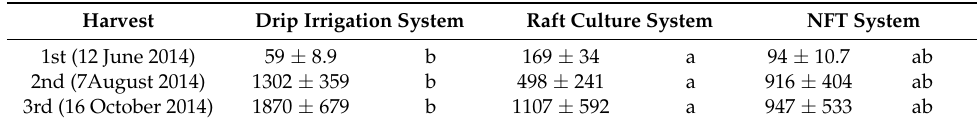
Table 7. Average manganese leaf mineral concentrations ( ± SD) in µ g · g − 1 shown for the three harvests comparing all three hydroponic systems. Different letters indicate significant differences (Tukey’s HSD, n = 3, p < 0.05) between HP